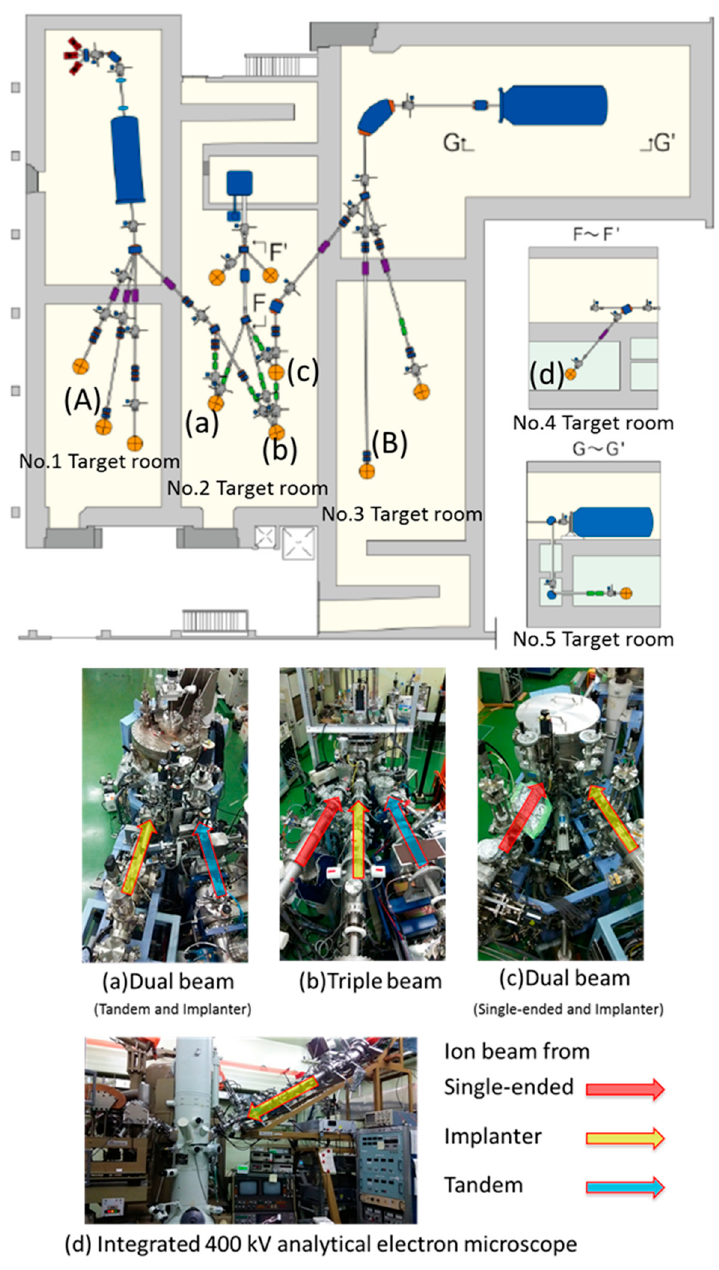
Figure 14. The layout of beam transport lines in the multiple beam irradiation facility and photographs of typical irradiation apparatus described in the text.